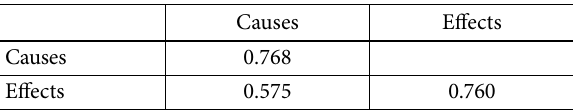
Table 6. Discriminant validity-variable correlation of Causes and effects of poor communication construct